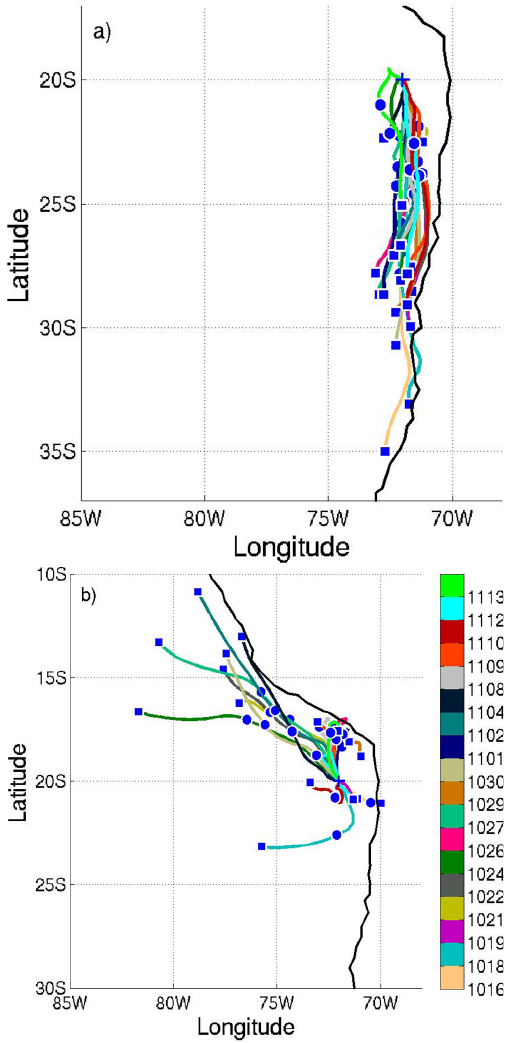
Fig. 4. (a) Two-dimensional isobaric back trajectories starting at 500m from Point Alpha (Plus sign) for the 18 cases (color bar) with the 24-h point (Blue Circle), and the 48-h point (Square); (b) three- dimensional back trajectories starting at 2000m from Point